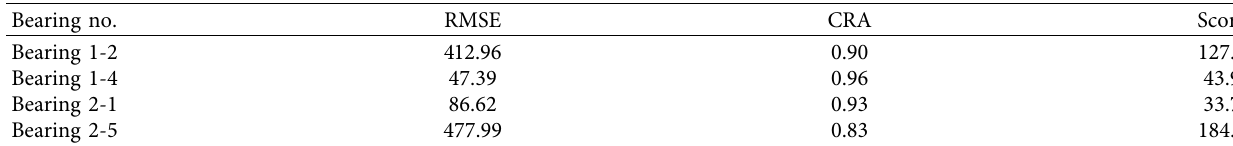
Table 6: Training set evaluation metric statistics.